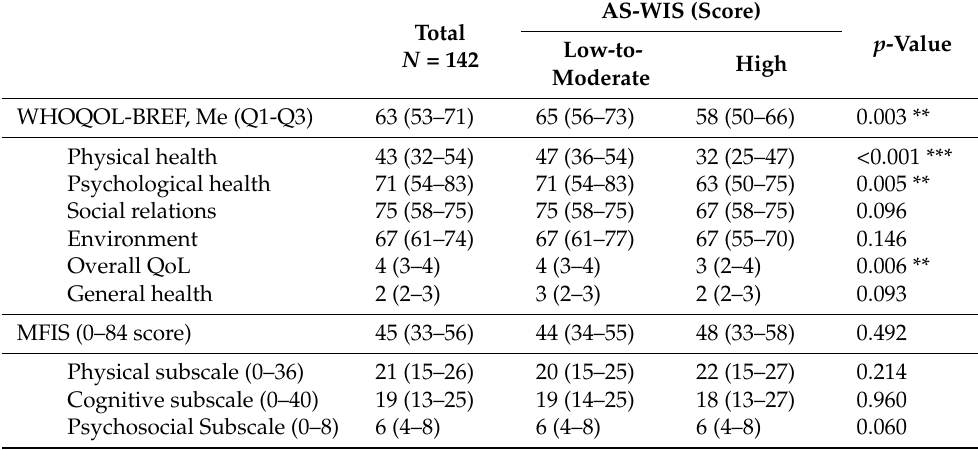
Table 7. QoL (WHOQOL-BREF) and fatigue levels (MFIS) in 142 patients with RA divided into two groups depending on the level of risk of work disability (AS-WIS), n